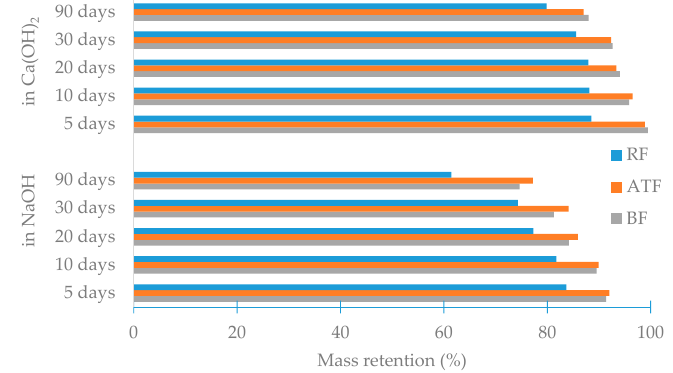
Figure 13. Change of fiber mass in sodium solution or calcium hydroxide solution.